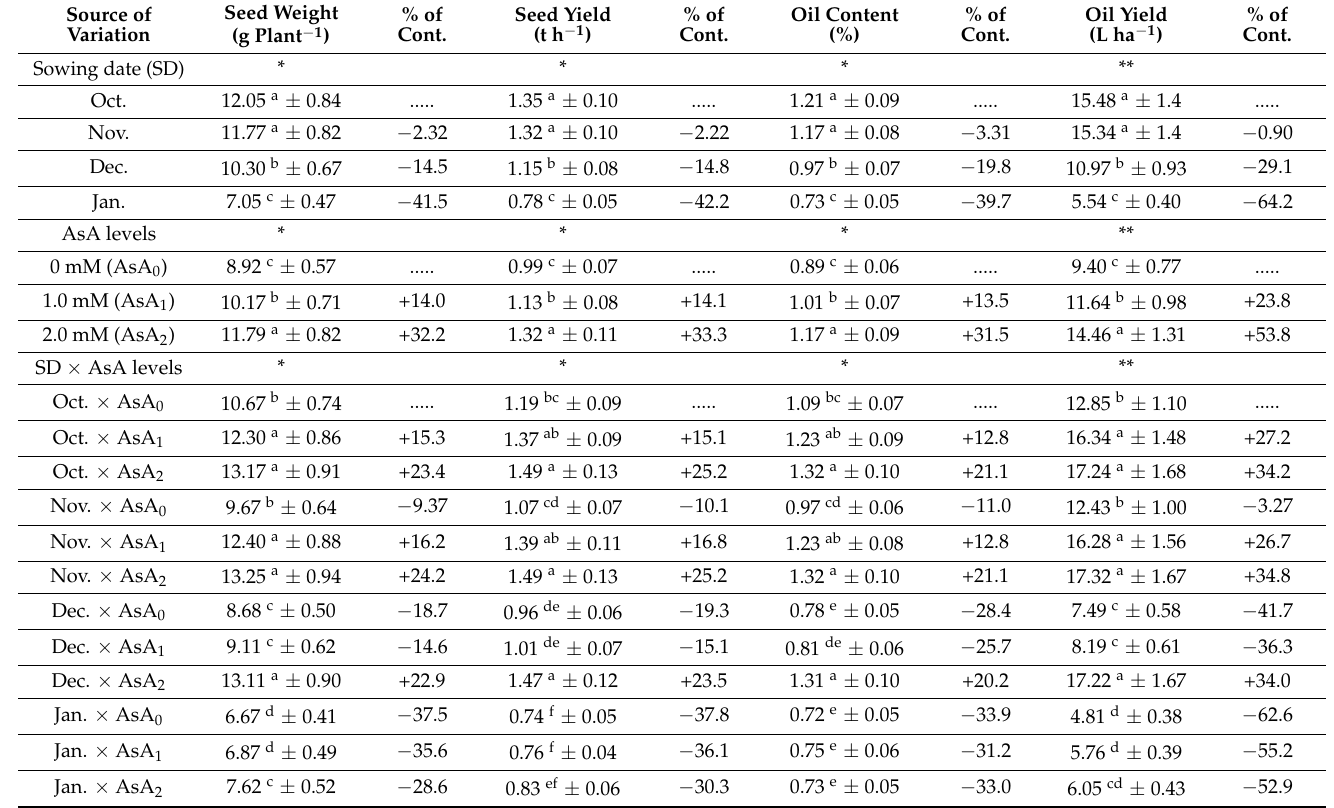
Table 2. Effect of integrative treatment of seeds and leaves with ascorbic acid (AsA) on seed and oil yield components of parsley plants under different sowing dates vs. October. All values are the average of the 2018/2019 and 2019/2020